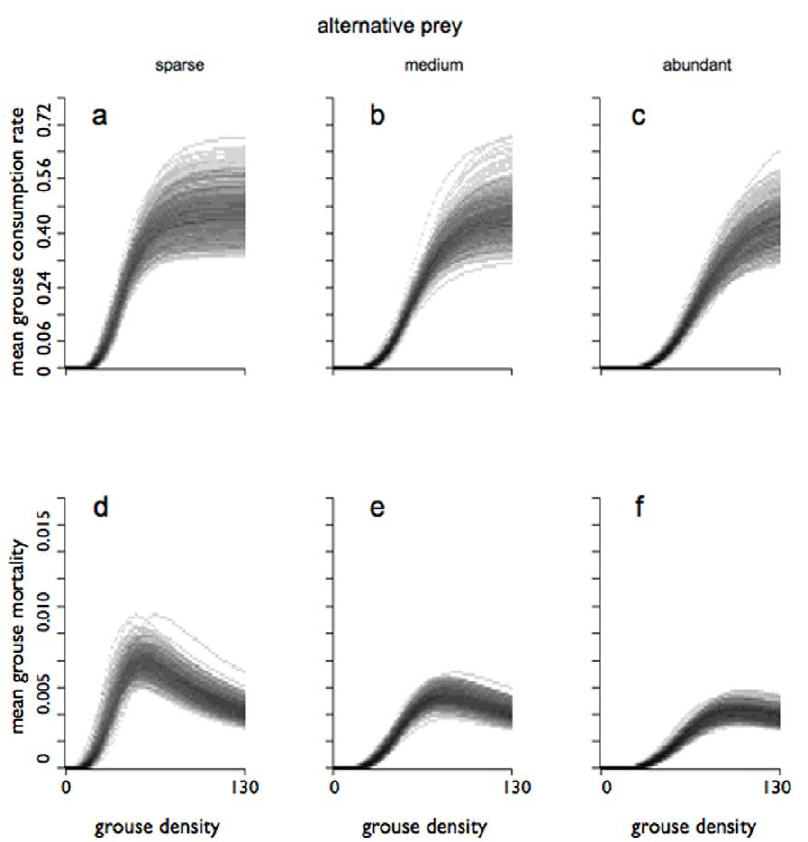
Figure 1. Estimated consumption rate and mortality rate for grouse chicks, as a function of grouse density. Estimated mean consumption is shown in the top row (a,b,c) and per capita mortality is shown in the bottom row (d,e,f), at various densities of alternative prey. Per capita grouse chick mortality was calculated as (hourly consumption rate)/(grouse chick density). The grey shades represent the posterior probability density at each point. In the left-hand column (a,d), both meadow pipits and field voles are at low densities (2 pipits counted per km of transect, and 0.1 voles caught per 100 trap nights, htn 2 1 ) , whereas in the right-hand column (c,f), both pipits and voles are abundant (20 pipits.km 2 1 , 4 voles.htn 2 1 ). The middle column (b,e) represents an intermediate case (9 pipits.km 2 1 ; 1 vole.htn 2 1 ).